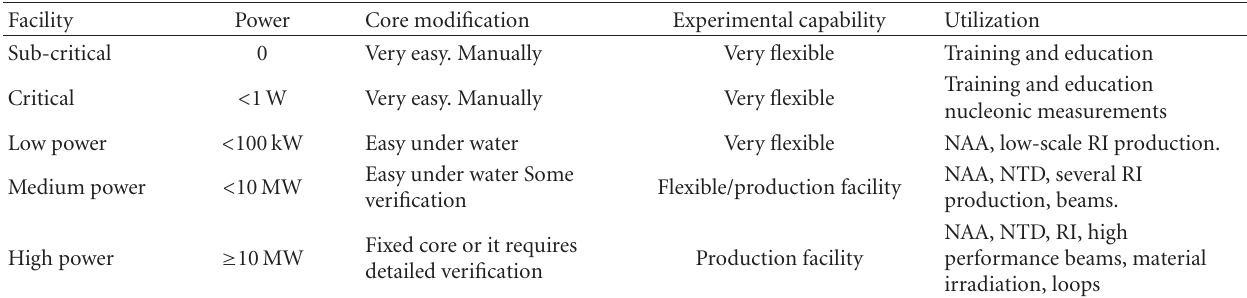
Table 1: Comparison of di ff erent